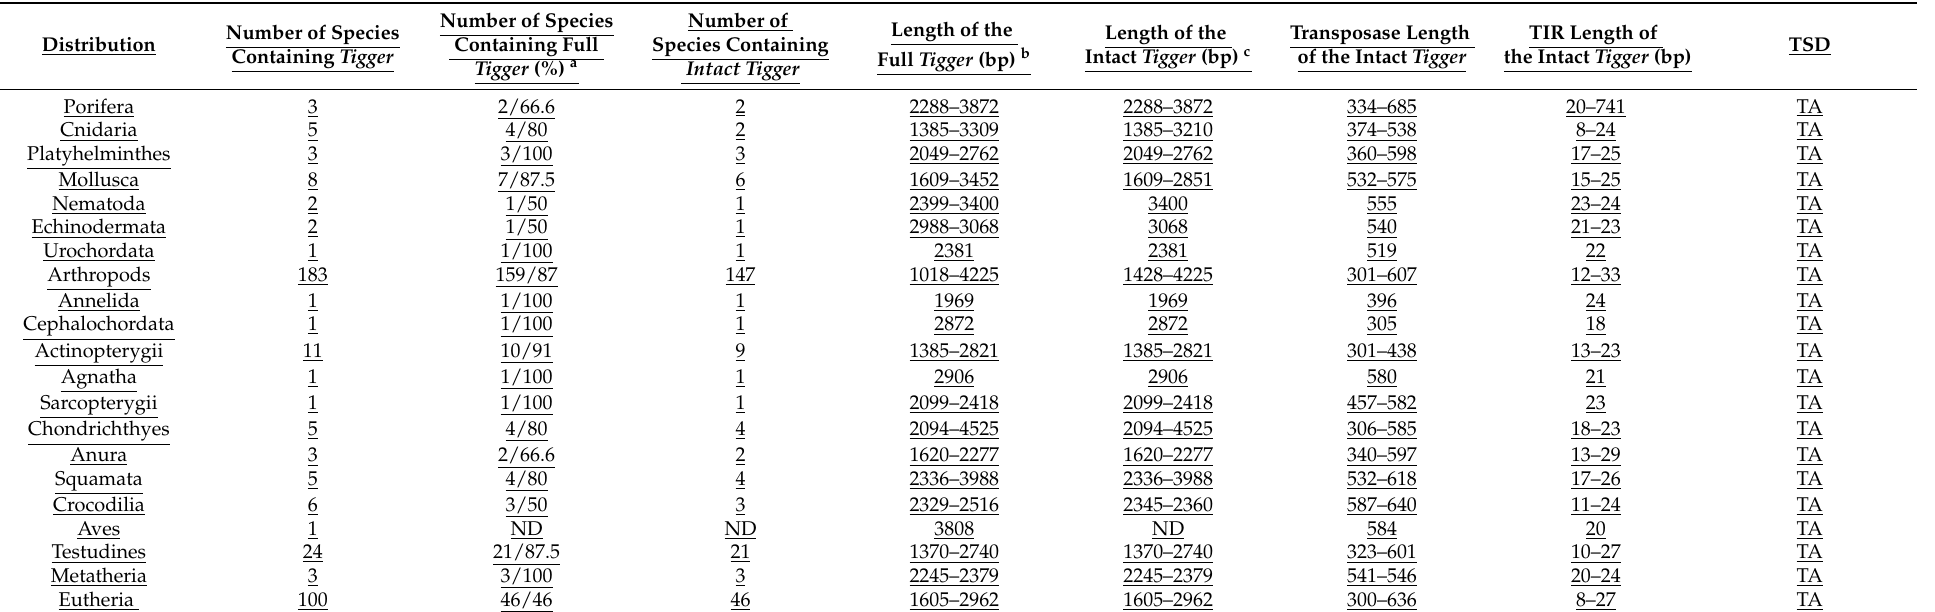
Table 1. Tigger distribution in all eukaryotes examined in this